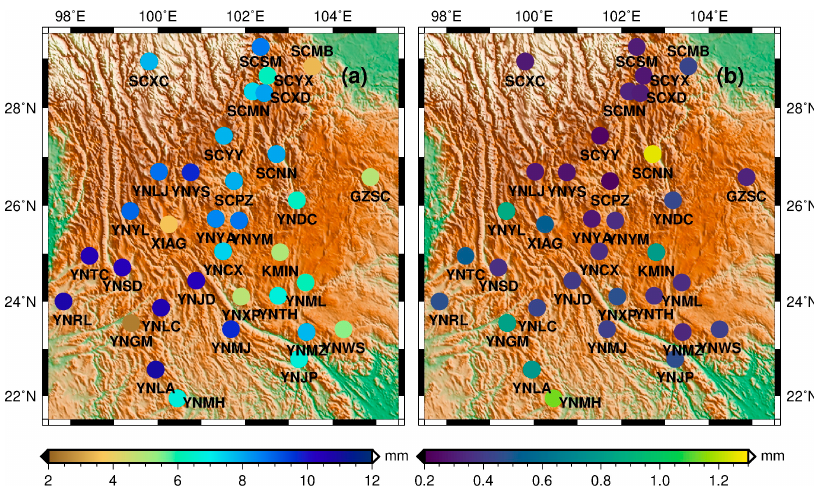
Figure 5. Distribution of ( a ) the annual amplitude and ( b ) its standard deviation (in mm) of the 34 GPS stations on a topographic base map.